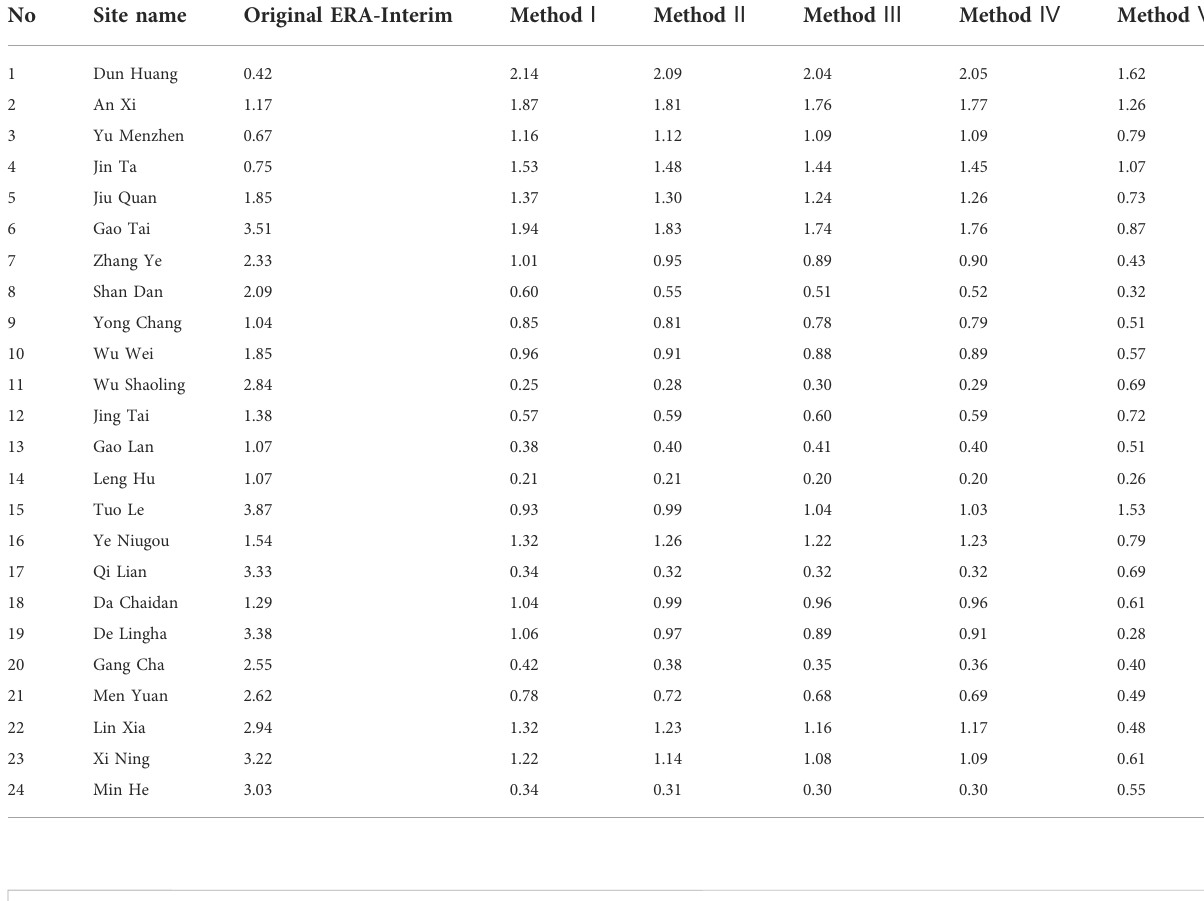
TABLE 7 RMSE ( ° C) between daily observed and original ERA-Interim temperature, and between observed temperature and data obtained from fi ve correction methods for 24 meteorological stations during the period 1979 – 2017. No